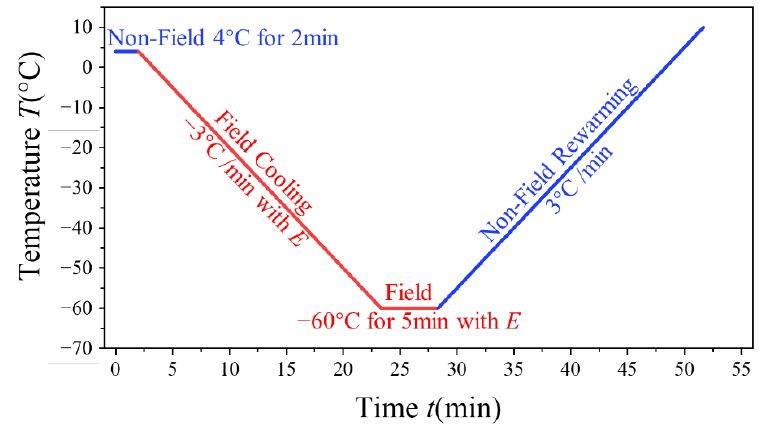
Figure 2. Temperature – time procedure for DSC measurement.